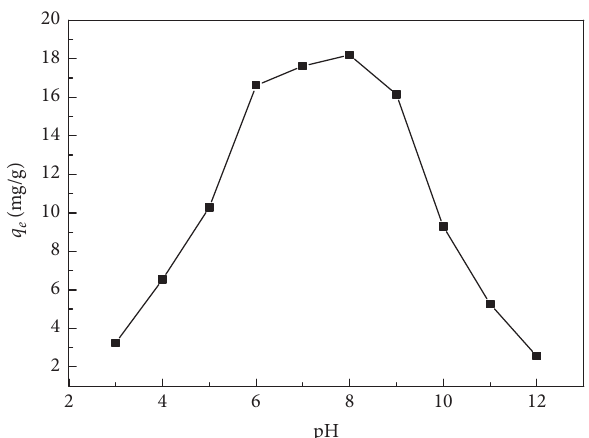
Figure 4: Effect of pH on ammonium adsorption (EMRZ dos- age � 0.2 g/100mL; initial ammonium concentration � 100mg/L; temperature � 25 ° C; contact time � 100min).